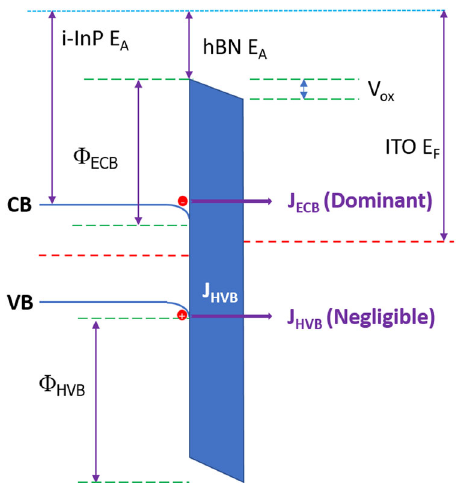
Fig. 6 Depiction of direct tunneling mechanism under interface charge carrier accumulation and depletion. A band diagram depicting the direct quantum mechanical tunneling from i-InP to ITO. Primarily two tunneling components can be calculated using Eq. (10): electron tunneling current from the conduction band ( J ECB ), and hole tunneling from the valence band ( J HVB ). ϕ ECB is the barrier height for electron tunneling from the i-InP conduction band with ITO, and ϕ HVB is the barrier height for holes tunneling from the i-InP valence band to ITO. Because ϕ ECB < ϕ HVB , and there is an accumulation of electrons at the interface, J ECB ≫ J HVB